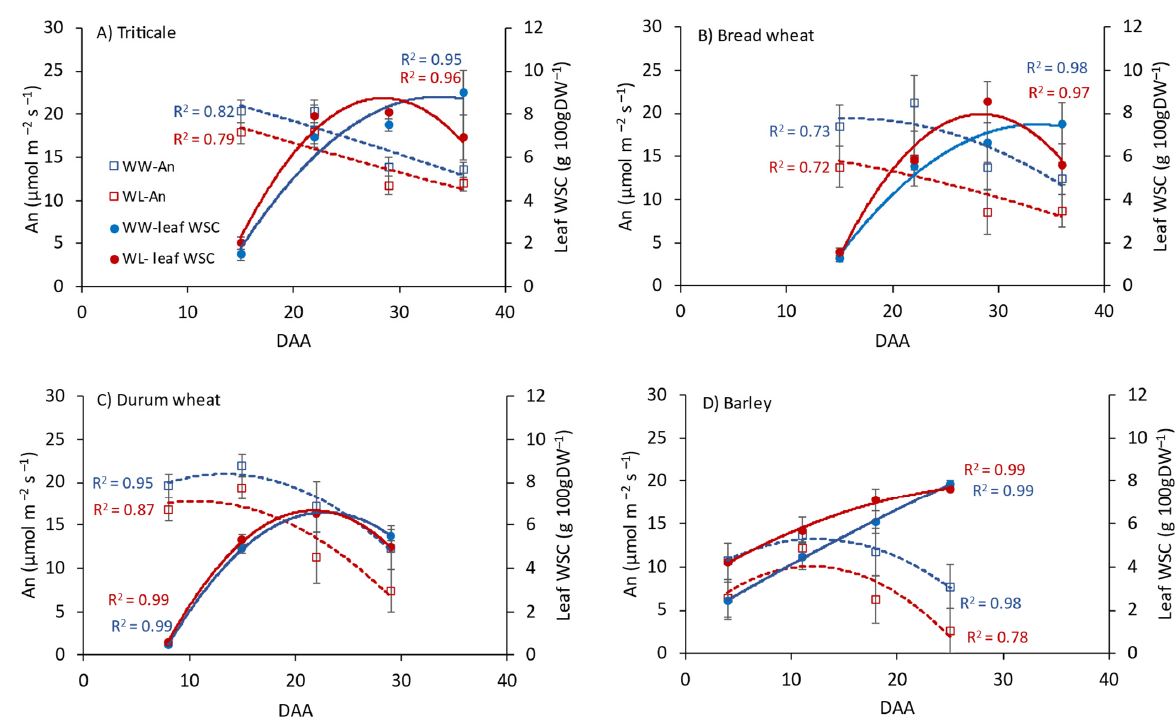
Figure 1. Time variation (expressed as days after anthesis, DAA) of flag leaf photosynthesis (An) and flag leaf water-soluble carbohydrates (WSCs) during the grain filling stage of ( A ) triticale, ( B ) bread wheat, ( C ) durum wheat, and ( D ) barley grown under well-watered (WW) and water-limited (WL) regimes. The regression equations are in Table S1.